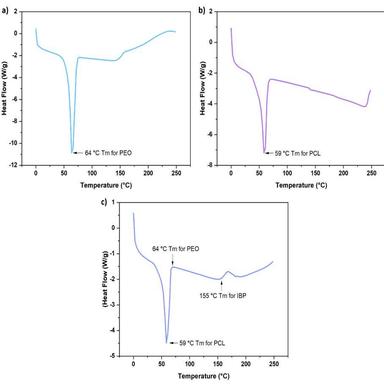
DSC thermograms of a) PEO–IBP, b) PCL–IBP and c) PCL:PEO–IBP.